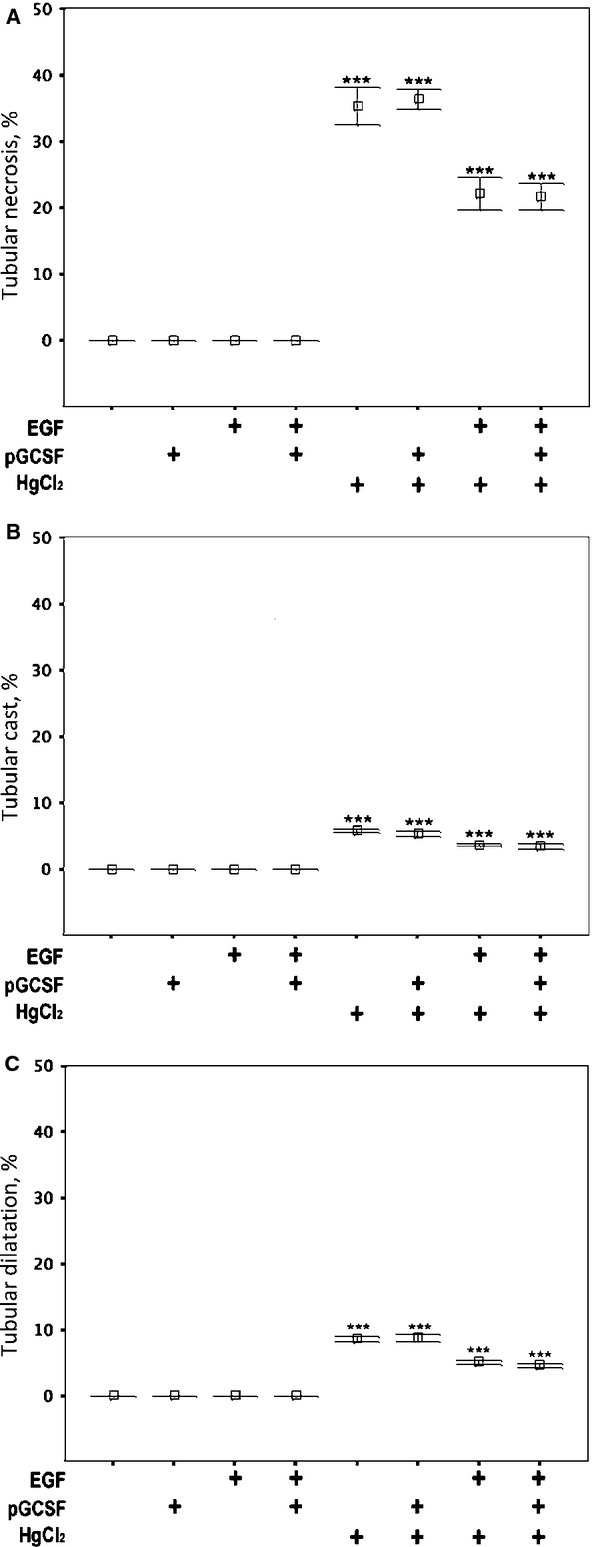
Attenuation of acute kidney injury by EGF and the absence of effects of P-GCSF. (A) Prevalence of tubular cell necrosis, (B) cast formation and (C) tubular dilatation after various treatments.